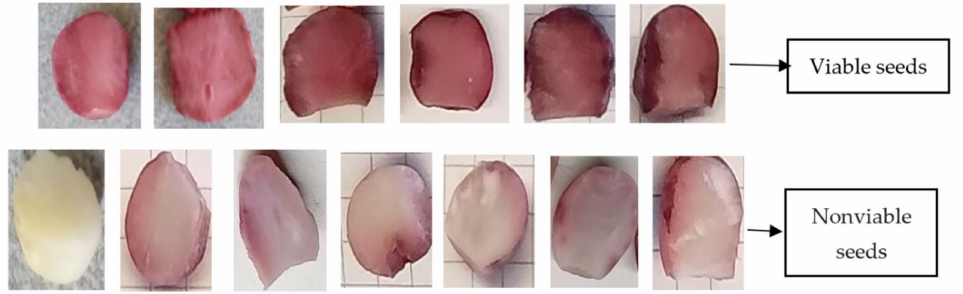
Figure 3. The different staining of the dissected seeds of D. steudneri after the tetrazolium test, used as a reference for the identification of viable and nonviable